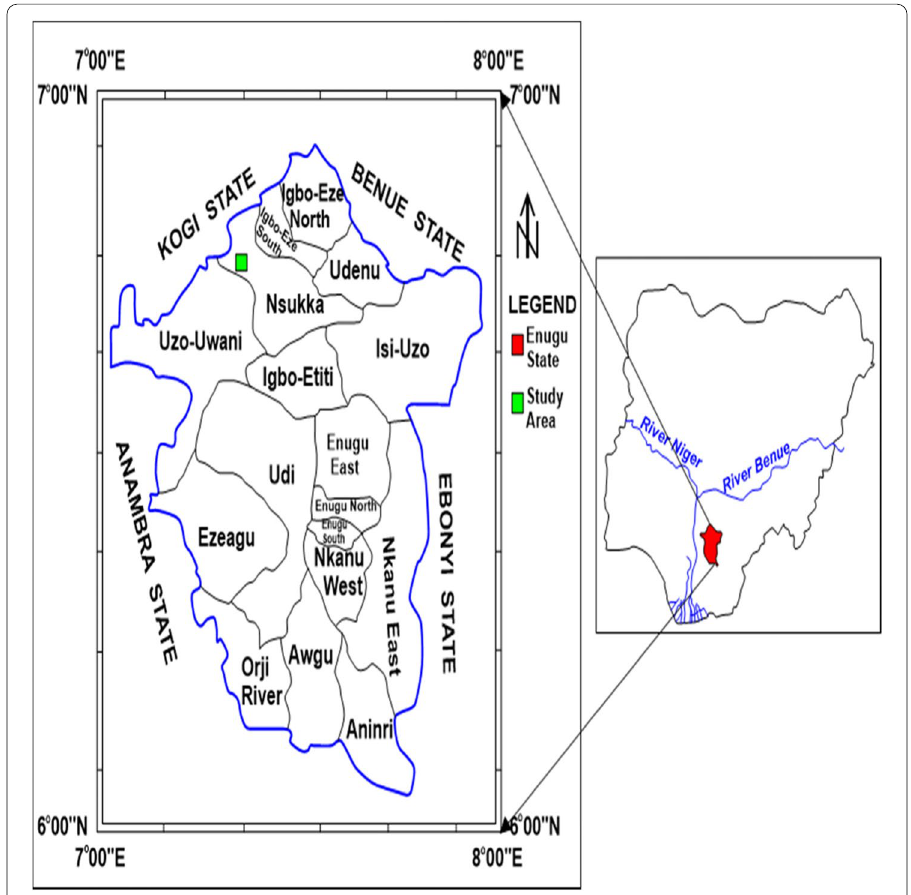
Fig. 1 Map of Enugu state showing the study